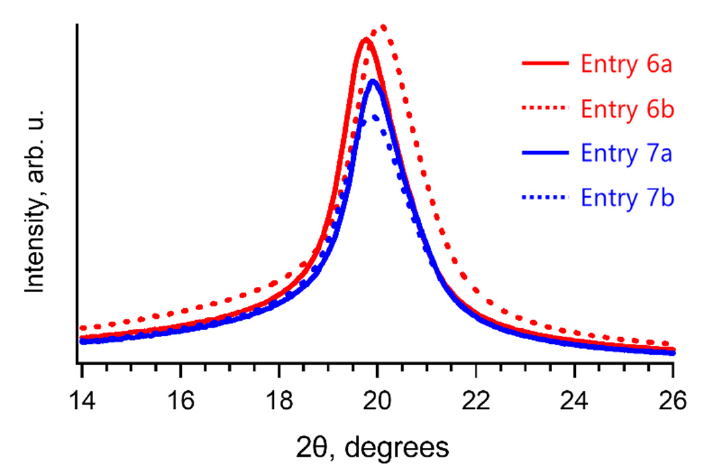
Figure 8. X-ray diffraction (XRD) patterns. Entry 6a (red solid line) is for PSA4.9k before TTC removal, and Entry 6b (red dashed line) is that after TTC removal. Entry 7a (blue solid line) is for PSA17k before TTC removal and Entry 7b (blue dashed line) is that after TTC removal.